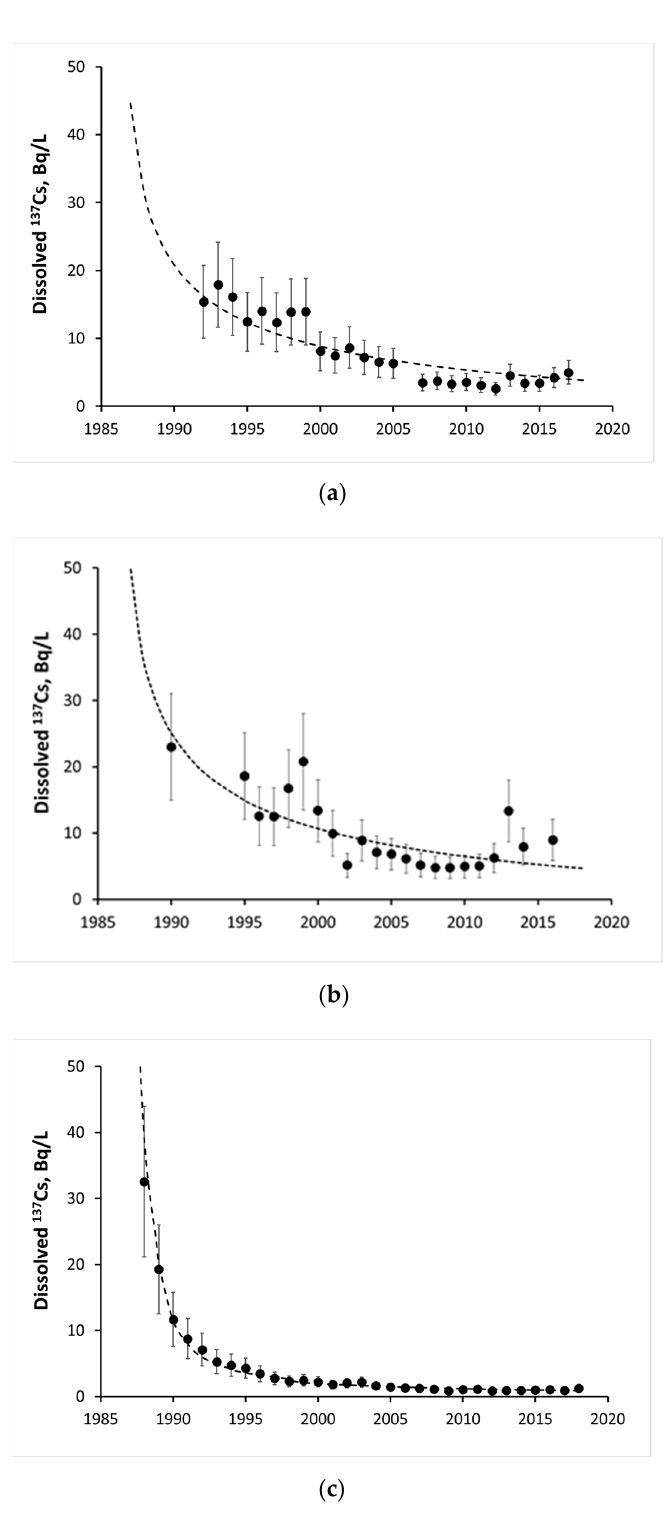
Figure 6. Time dependence of annual averaged monitoring data on dissolved 137 Cs activity concen- trations in the studied water bodies (black circles) versus calculations by the semiempirical diffusional model (dashed lines): ( a )—Lake Glubokoe, ( b )—Lake Azbuchin, and ( c )—ChNPP cooling pond. In model calculations K d ( 137 Cs) was taken to be constant and equal to 3.5 × 10 4 L/kg for Lake Glubokoe and 5.5 × 10 4 L/kg for Lake Azbuchin. K d ( 137 Cs) in the cooling pond was assumed to increase from 5.5 × 10 4 L/kg in 1986–1987 to 3.0 × 10 5 L/kg in 1997, remaining constant since then. D eff was taken to be 0.1 cm 2 /y for all three water bodies.